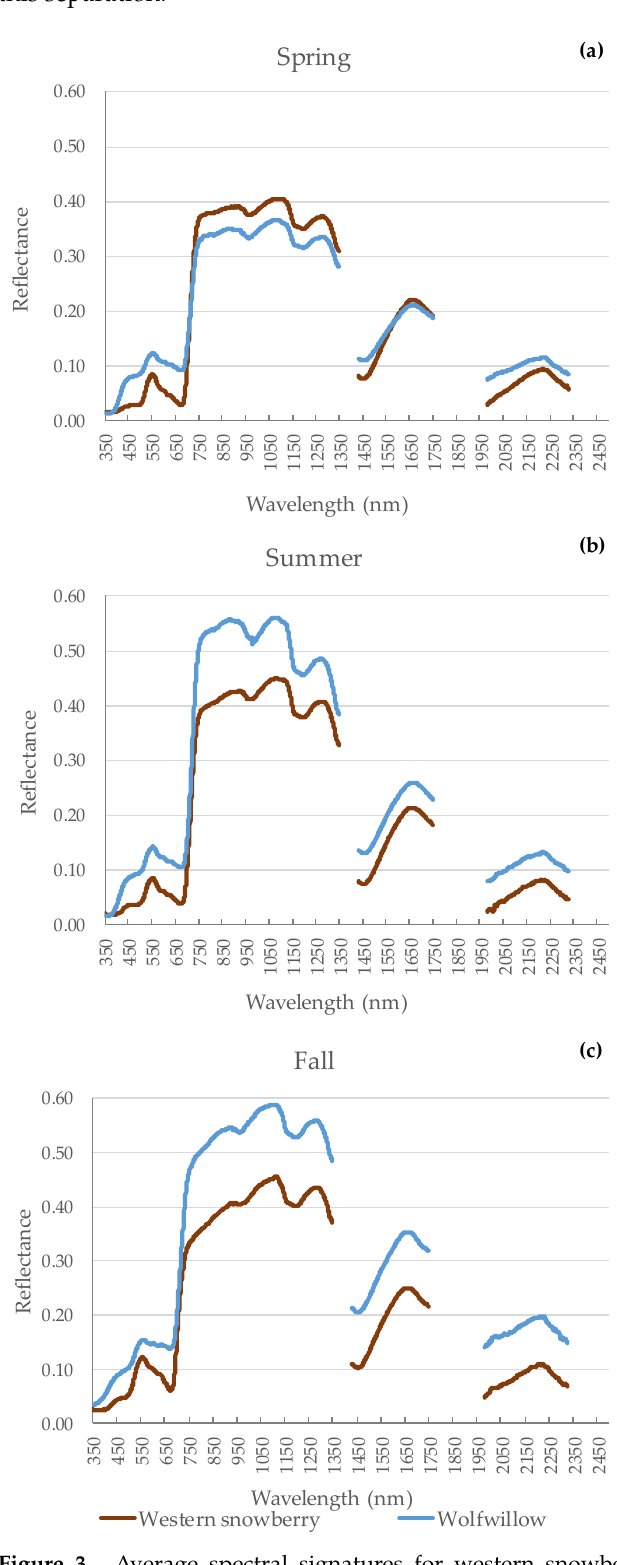
Figure 3. Average spectral signatures for western snowberry and wolfwillow in ( a ) spring, ( b ) summer, and ( c ) fall (water absorption regions between 1350–1430 nm, 1750–1980 nm, and 2330–2500 nm have been removed; the data are available on Figshare https://doi.org/10.6084/m9 .figshare.14541597.v1 (accessed on 21 June